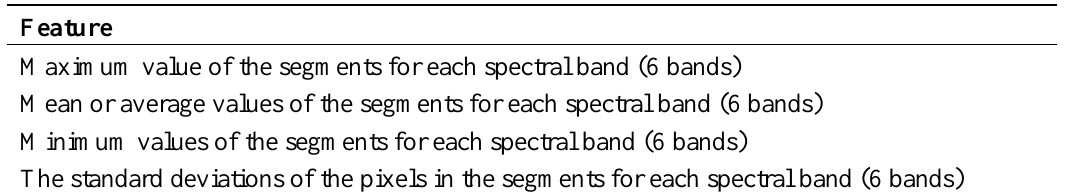
Table 3. The features used in the objected-based classification